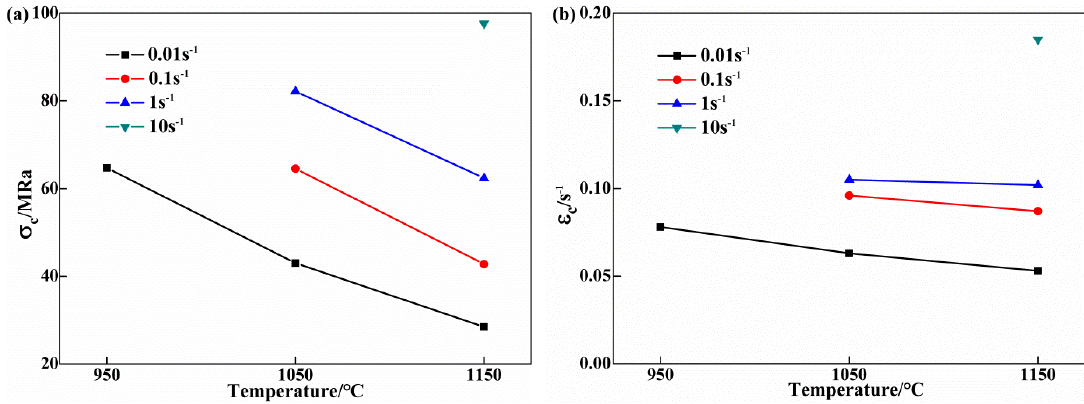
Figure 10. Curves of ( a ) σ c versus T and ( b ) ε c versus T for 35CrMo steel under different deformation conditions.